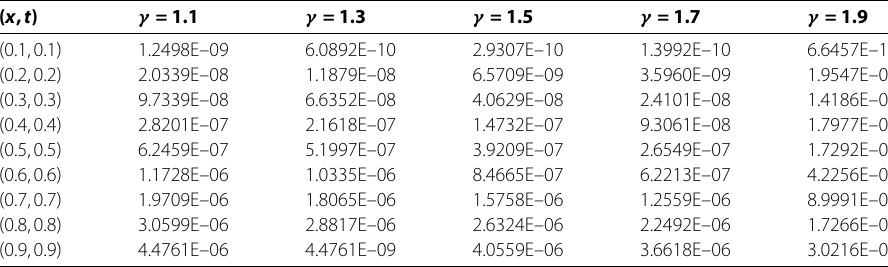
Table 6 Absolute errors of Example 3 for several values of γ at different points